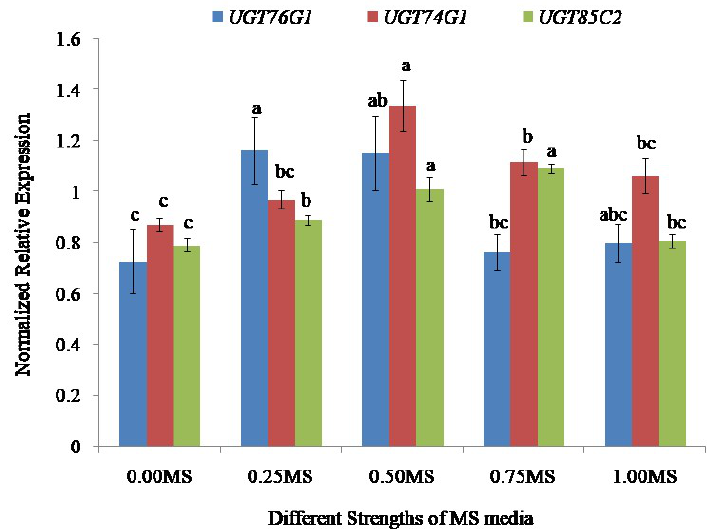
Figure 10. Expression levels of UGT76G1, UGT74G1, and UGT85C2 in stevia grown on 0.00, 0.25, 0.50, 0.75 and 1.00 strengths of MS media. The expression was normalized with three reference genes Actin (AF548026.1), Aquaporin (DQ269455.1), and Calmodulin (AF474074.1). Bars denote the mean of three biological replications per treatment ± SE (standard error). Mean values with the same letters are not significantly different based on the Student’s t -test at p = 0.05 .